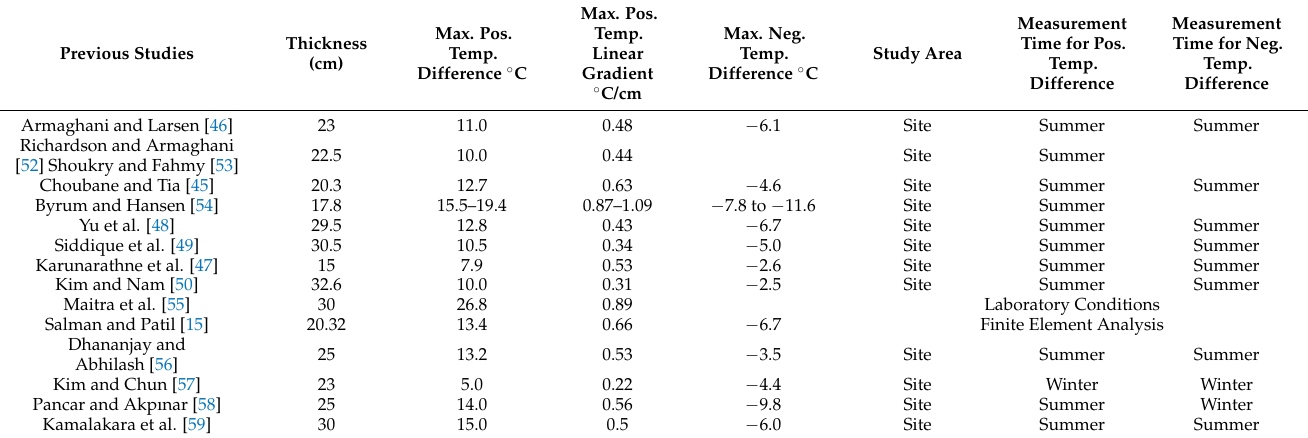
Table 8. Maximum positive and negative temperature differences in literature